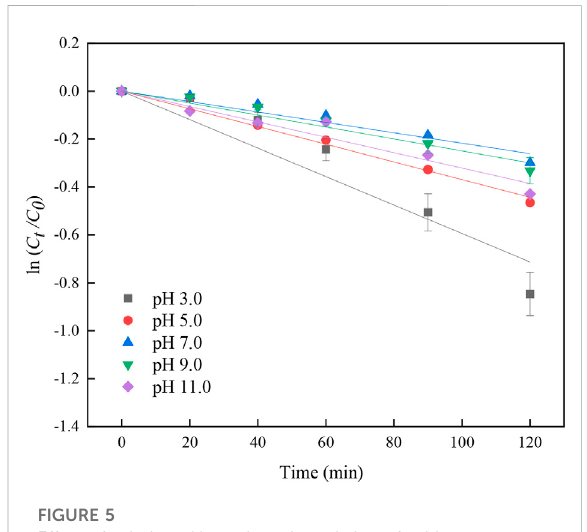
FIGURE 6 Effect of light intensity on photodegradation of acid orange 8 by